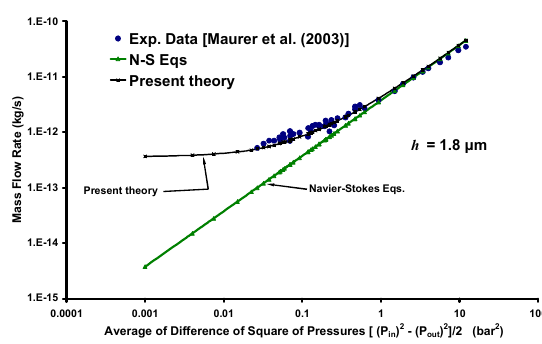
Fig. 7: Comparison of mass flow rate as a function of composite pressure drop (difference of squares of pressures), for helium, against the experimental data of Maurer et al. (2003).